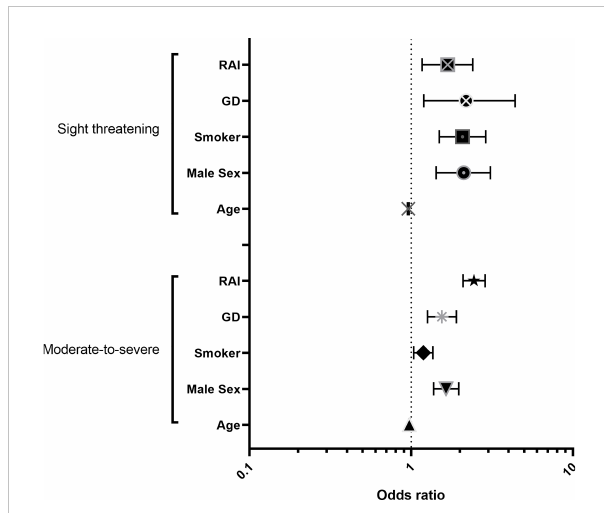
FIGURE 3 Odds ratio plot for the multiple logistic regression models depicting Odds ratios for the predicting factors and their 95% con fi dence interval; Model 1 is predicting occurence of moderate-to-severe GO, and Model 2 of sight-threatening